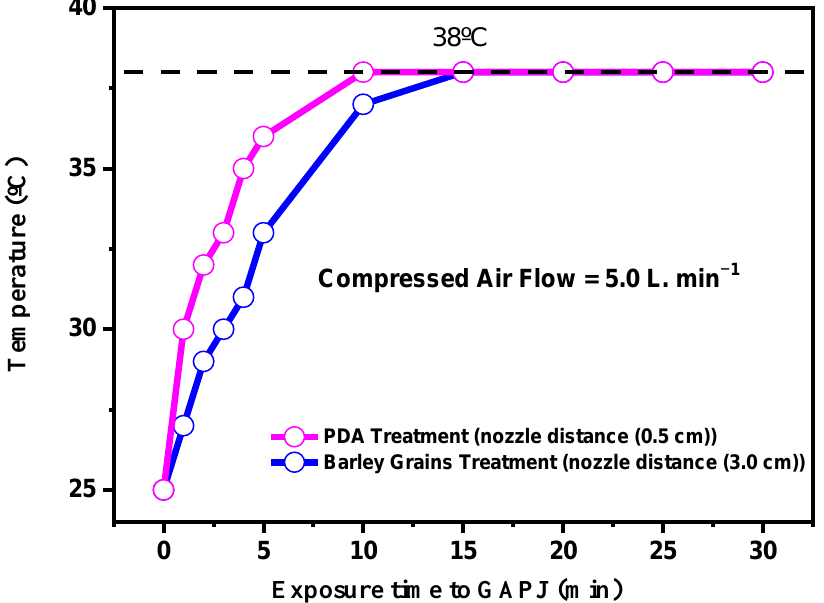
Figure 3. Temperature as a function of exposure time to GAPJ for both PDA and barley grain treat-